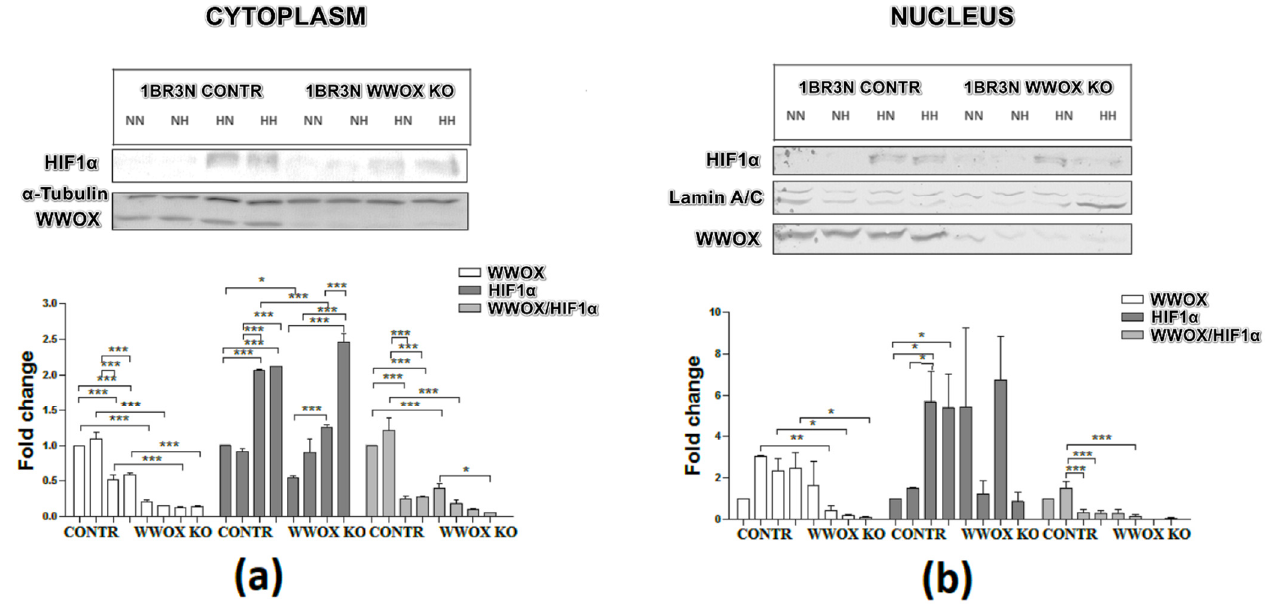
Figure 6 . WWOX and HIF1 α western blot analysis of cytoplasmic ( a ) and nuclear ( b ) fractions of CONTR and WWOX KO 1BR.3.N cells after 48h incubation in four tested condition. Results of ANOVA with a post-hoc Tukey-Test are shown as mean ± SEM. *, p < 0.05; **, p < 0.01; ***, p < 0.001; NN—normoxia normoglycemia, NH—normoxia hyperglycemia, HN—hypoxia normoglycemia, HH—hypoxia hyperglycemia.